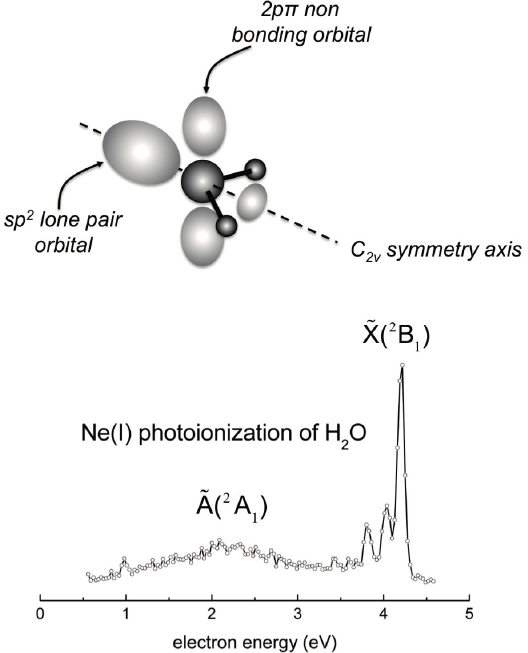
Figure 3. The structure of water molecules in the gas phase, with a C 2v molecular axis and a sp 2 hybridization, is depicted. The ground state X( 2 B 1 ) H 2 O + ion is formed by the removal of one electron from the 2p π lone pair orbital, while for the formation of the excited A( 2 A 1 ) H 2 O + ion, the electron must be removed from the 3a 1 sp 2 lone pair orbital. The electron energy spectrum obtained in photoionization of water molecules by using Ne(I) photons is also shown. The two bands in the spectrum are related to the formation of H 2 O + in its ground X( 2 B 1 ) electronic state (at higher electron energy), and in the first excited A( 2 A 1 ) electronic state (at lower electron